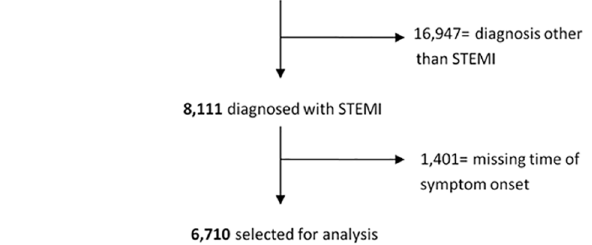
Fig 1. Study Flow. Of 25,058 patients registered in the Singapore Myocardial Infarction Registry (SMIR), 6,710 who were diagnosed with STEMI and with known times of symptom onset were selected for analysis.